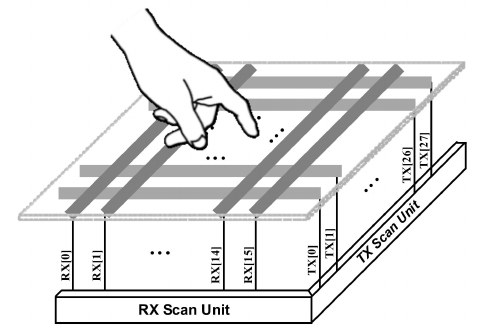
Figure 1. Finger touch